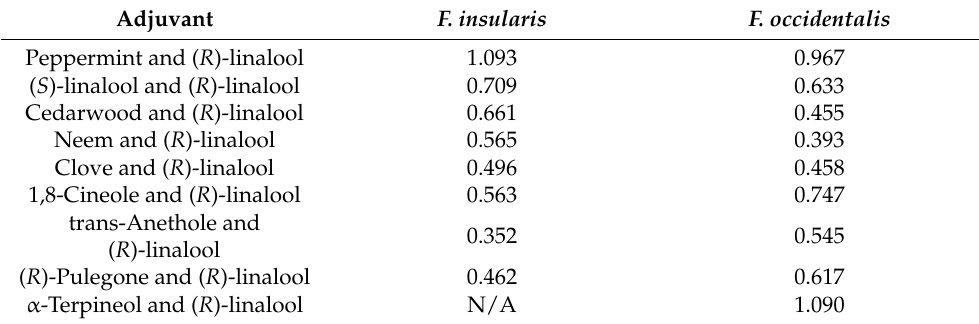
Table 3. Synergistic ratios (SRs) of adjuvants to ( R )-linalool for F. insularis and F. occidentalis . Adjuvant F. insularis F. occidentalis Peppermint and ( R )-linalool 1.093 0.967 ( S )-linalool and ( R )-linalool 0.709 0.633 Cedarwood and ( R )-linalool 0.661 0.455 Neem and ( R )-linalool 0.565 0.393 Clove and ( R )-linalool 0.496 0.458 1,8-Cineole and ( R )-linalool 0.563 0.747 trans-Anethole and 0.352 0.545 ( R )-linalool ( R )-Pulegone and ( R )-linalool 0.462